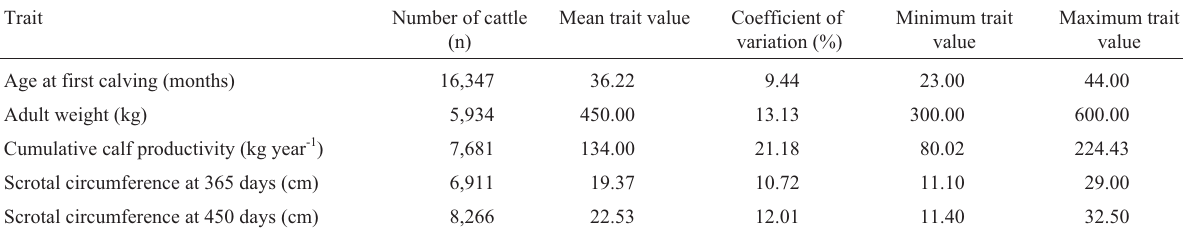
Table 1 - Descriptive statistics for all variables included in the analyses.